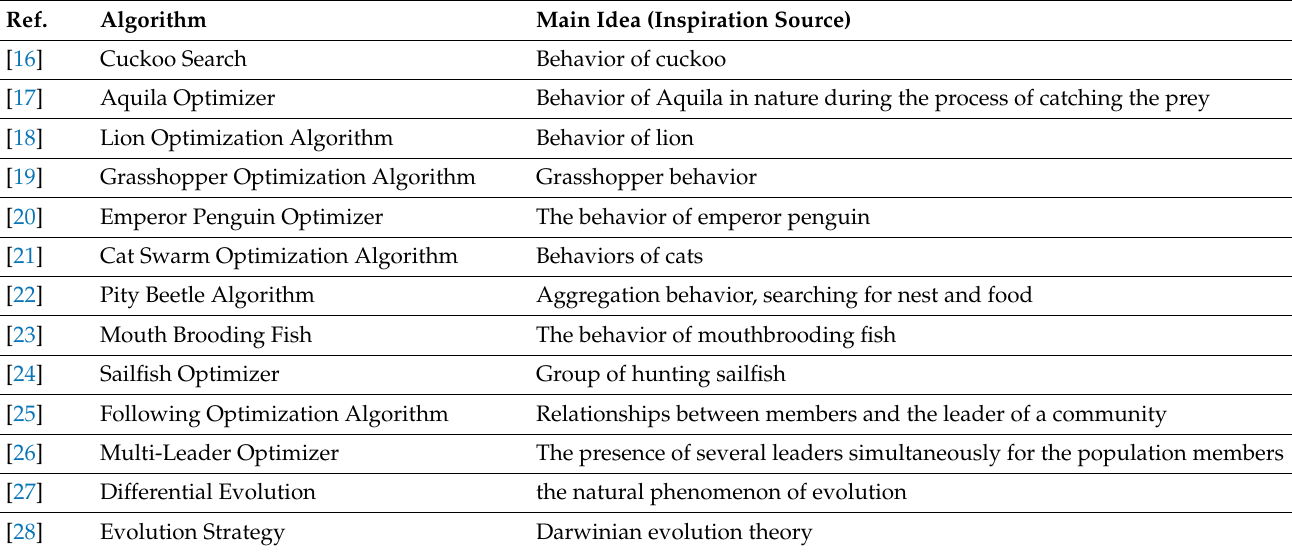
Table 1. Proposed well-known optimization algorithms in the recent literature.